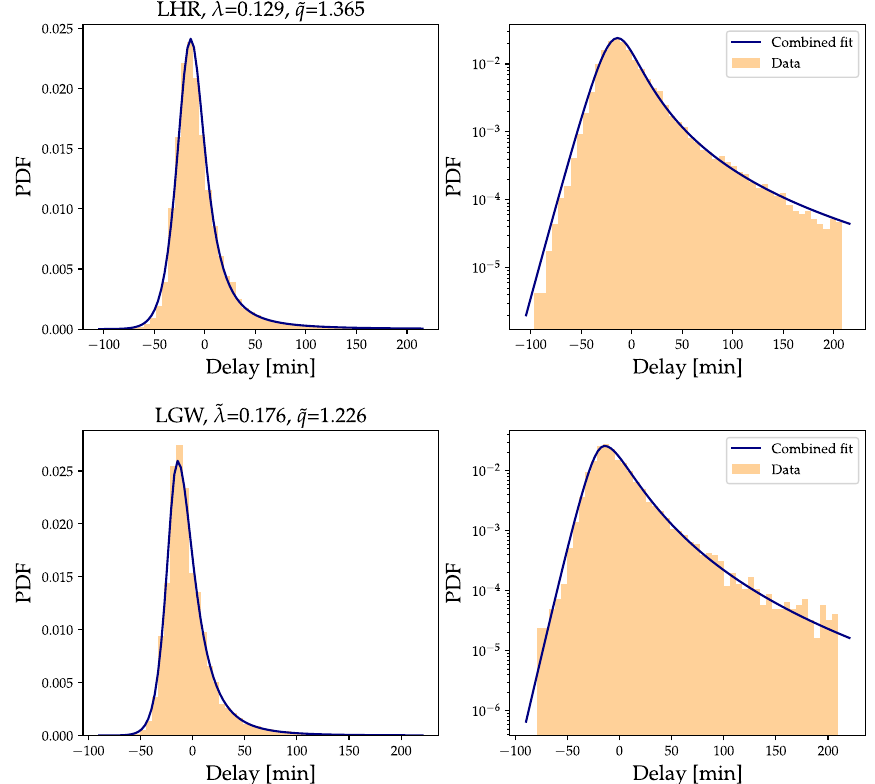
Figure 10. Using the approximately Gaussian shape in the center, we smoothly combine left and right flank fits into one coherent fit of the full delay data set. To emphasize the quality of the fit, we display both a linear (left) and logarithmic (right) scale of the PDF for LHR (top) and LGW (bottom), the two airports with the most flights in our data